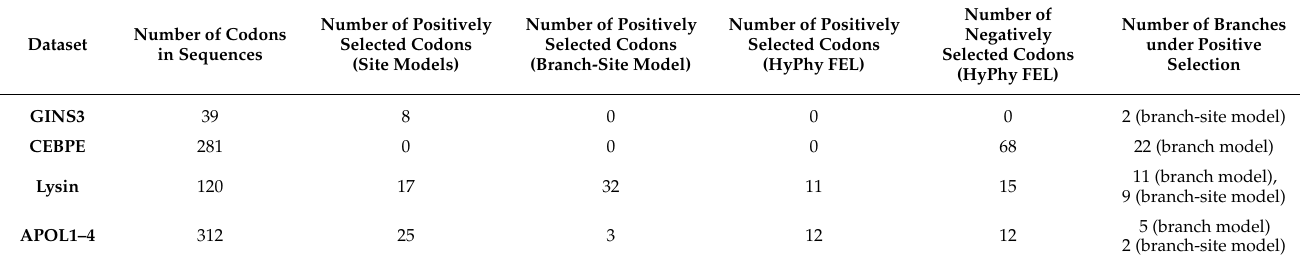
Table 3. Results of the selection analyses. The number of branches under positive selection detected by the branch-site model did not include branches with significant LRT results but without sites under positive selection. Overlaps between found sites were counted for all models with which they were